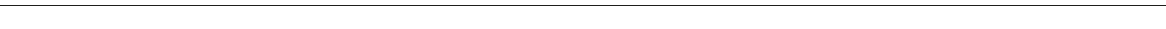
Fig. 5 ADK binds with SAHH to facilitate H3K4 methylation and endothelial in fl ammation. a Co-immunoprecipitation ( co-IP ) of overexpressed SAHH and endogenous ADK in HUVECs. Upper : IP was performed with mouse anti-His antibody followed by immunoblotting with rabbit anti-ADK antibody and rabbit anti-SAHH antibody. Lower : IP was performed with goat anti-ADK antibody followed by immunoblotting with rabbit anti-SAHH antibody and rabbit anti-ADK antibody ( n = 4). b Co-IP of endogenous SAHH and ADK in vehicle or TNF- α (10 ng/ml for 12 h)-treated HUVECs. Upper : IP was performed with goat anti-ADK antibody followed by immunoblotting with rabbit anti-SAHH antibody and rabbit anti-ADK antibody. Lower , Quanti fi cation of ADK – SAHH complex amount; control indicates no TNF- α treatment ( n = 4). c The activity of SAHH in TNF- α (10 ng/ml for 12 h)-treated ADK KD or Ctrl HUVECs ( n = 4). d Western blot detection and densitometric quanti fi cation of adhesion molecule expression and H3K4 methylation in TNF- α (10 ng/ml for 4 h)- treated ADK KD or Ctrl HUVECs preincubated with 20 µ M adenosine-2 ′ , 3 ′ -dialdehyde (Adox) for 30 min ( n = 4). e Western blot detection of adhesion molecules and H3K4 methylation in vehicle or TNF- α (10 ng/ml for 4 h)-treated Ctrl- or SAHH-overexpressing HUVECs ( n = 3). f Densitometric quanti fi cation of adhesion molecule expression and H3K4 methylation in TNF- α -treated Ctrl- or SAHH-overexpressing HUVECs ( n = 3). g Western blot detection and densitometric quanti fi cation of adhesion molecule expression and H3K4 methylation in TNF- α (10 ng/ml for 4 h)-treated vehicle or adenosine pre-incubated control or SAHH-overexpressing HUVECs ( n = 4). h Western blot detection and densitometric quanti fi cation of adhesion molecule expression and H3K4 methylation in TNF- α (10 ng/ml for 4 h)-treated Ctrl or ADK KD/SAHH-overexpressing HUVECs ( n = 4). All images are representative. For all bar graphs , data are the mean ± SEM, * P < 0.05 and ** P < 0.01 (Unpaired, two-tailed Student ’ s t -test for b , c ; one-way ANOVA with Tukey ’ s post hoc test for d , and f – h